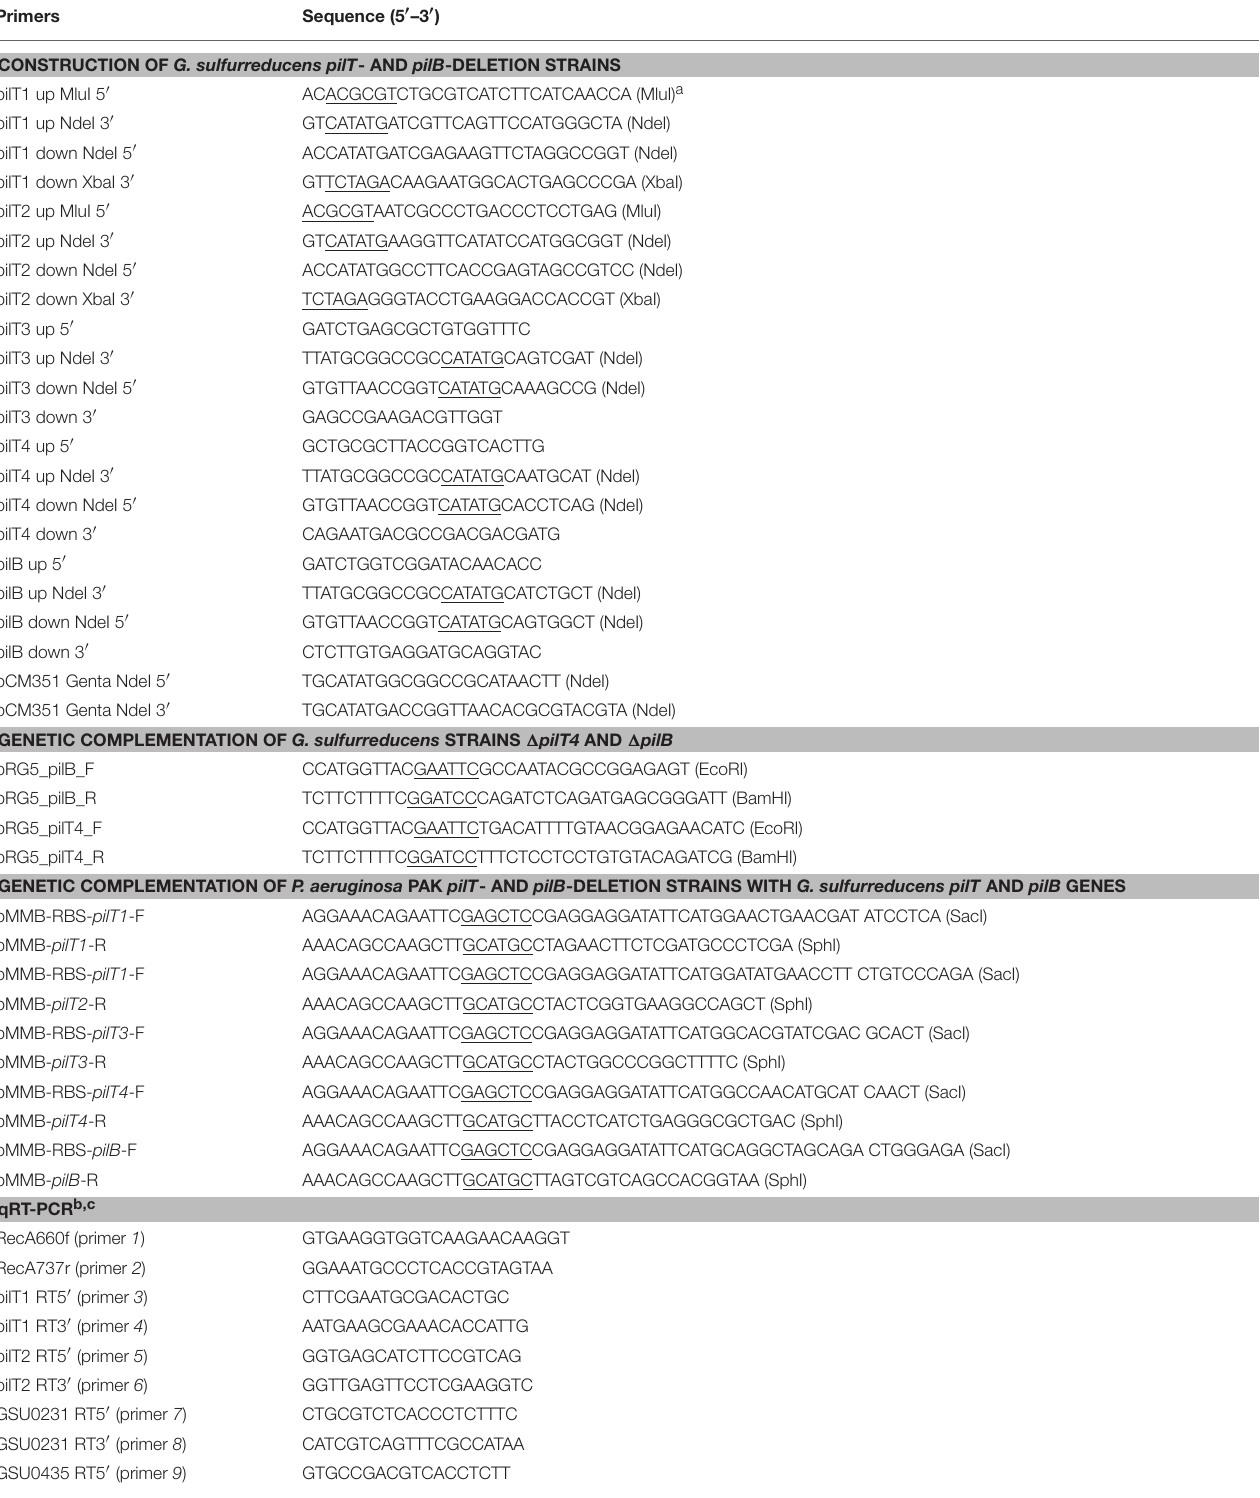
TABLE 2 | Primers used in this